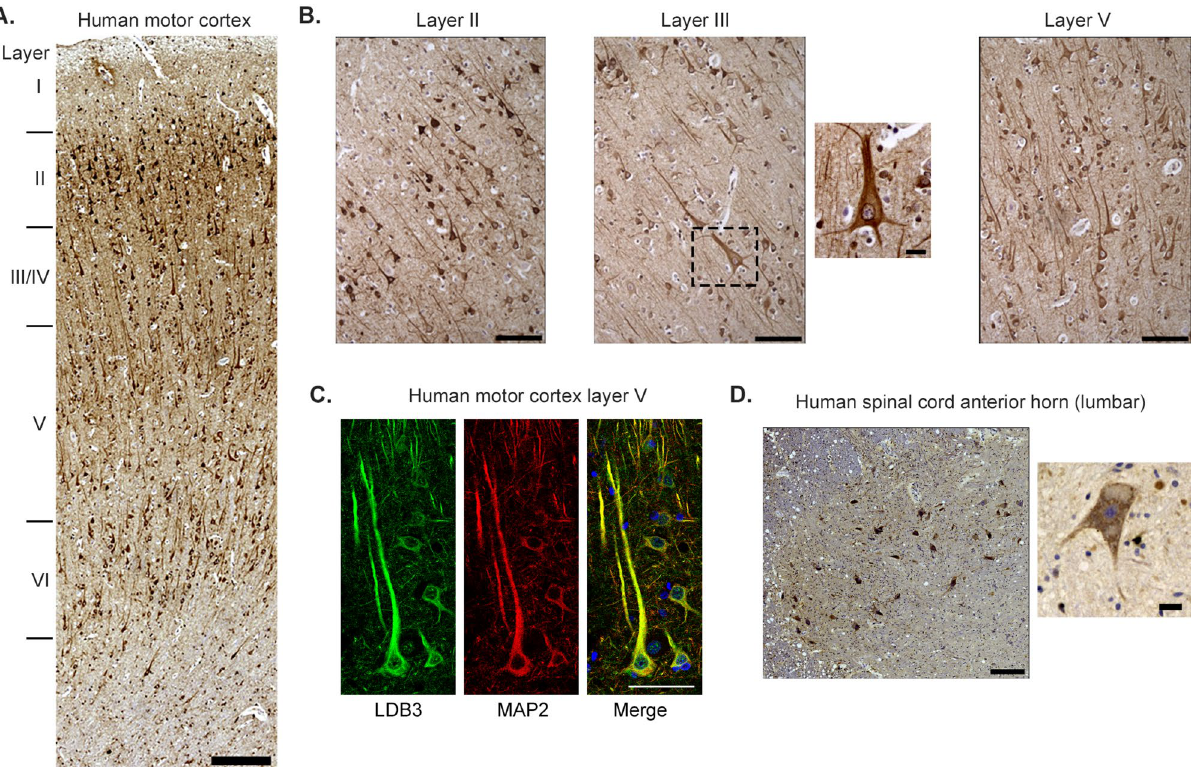
Figure 3. Immunolocalization of LDB3 in human motor cortex and the L1-L2 spinal cord anterior horn. ( A ) Immunohistochemistry staining with GTX115593 antibody shows LDB3 immunoreactivity in neurons of the motor cortex layers. ( B ) Images show neurons of layers II, III, and V at a higher resolution. The LDB3 signal is seen in the soma and processes of the neurons. ( C ) Immunofluorescent staining with the same antibody shows LDB3 (green) in the soma and dendrites of MAP2 co-stained (red) pyramidal neurons of layer V in the motor cortex. ( D ) Immunohistochemistry staining with the same antibody shows LDB3 immunoreactivity in the soma and processes of the anterior horn neurons in lumbar segments of the spinal cord. Scale bar 250 µm ( A and D ), 100 µm ( B ), 50 µm ( B inset and C ), and 20 µm ( D